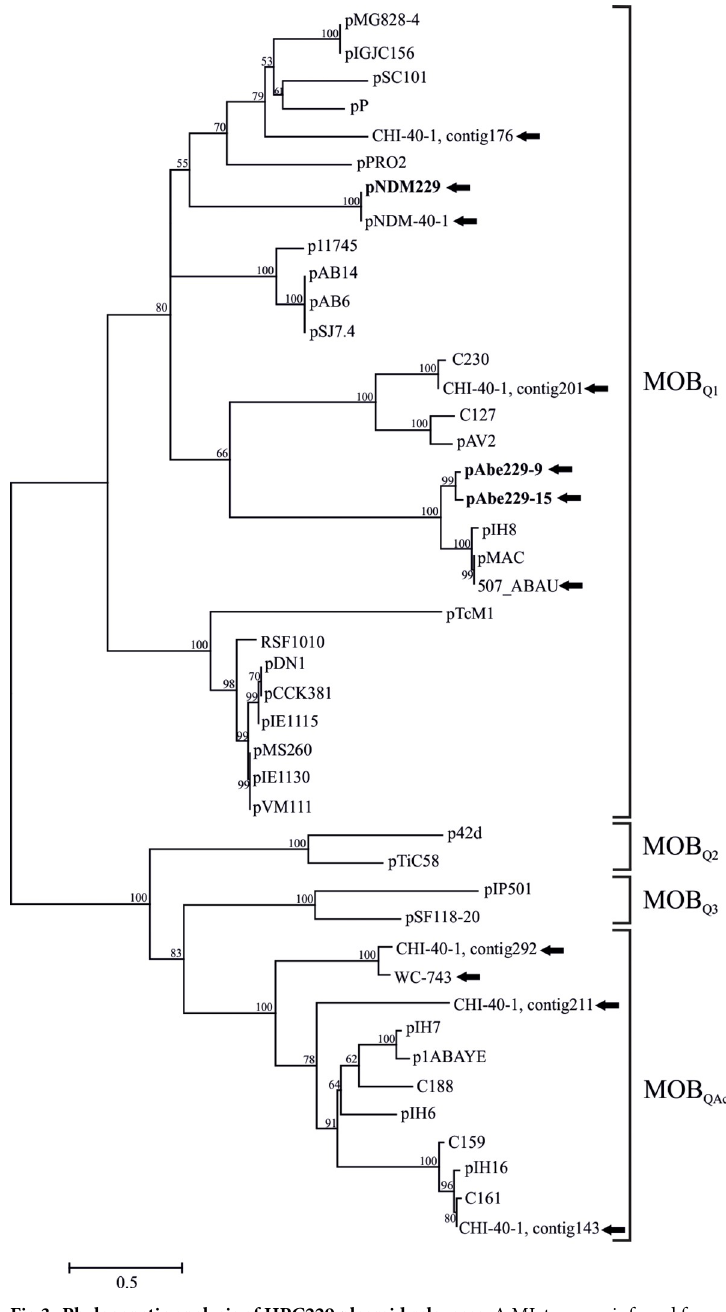
Fig 3. Phylogenetic analysis of HPC229 plasmid relaxases. A ML tree was inferred from the alignments of the first 300 amino acids of the N-terminal domains of MOB Q relaxases from A . bereziniae and the Acinetobacter local database [3,30].The MOB Q1 , MOB Q2 , MOB Q3 and MOB QAci sub-families are indicated. Relaxases encoded in A . bereziniae genomes are specified with black arrows, and those corresponding to HPC229 plasmids are additionally highlighted in bold. In the case of the CHI-40-1 draft genome (GenBank accession number CDEL01000000.1), the contig number in which a given relaxase gene was identified is additionally indicated. The evolutionary scale (number of amino acid substitution per site) is indicated at the botton left. Bootstrap values higher than 50% (100 replications) are indicated at the branching nodes of the ML tree.